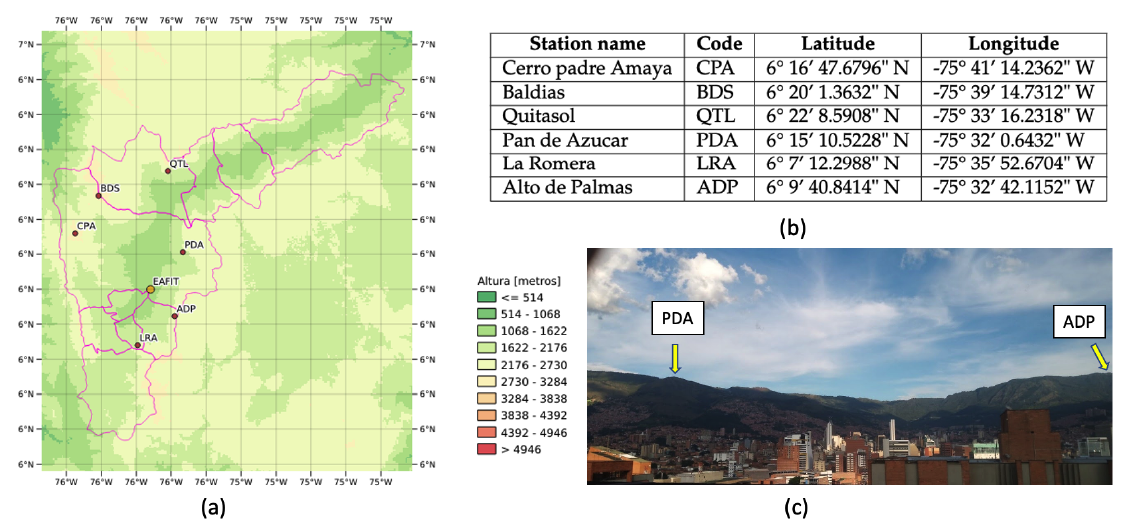
Figure 3. ( a ) Locations selected for the air quality network disposition around the surrounding mountains. The red cross is located at the point of view in the right direction from the arrow of the ( c ) photo. ( b ) table with the code and station coordinates. ( c ) The landscape of Medellín with the image of the east mountains of the valley and the disposition of two stations over the urban areas of this deep-seated